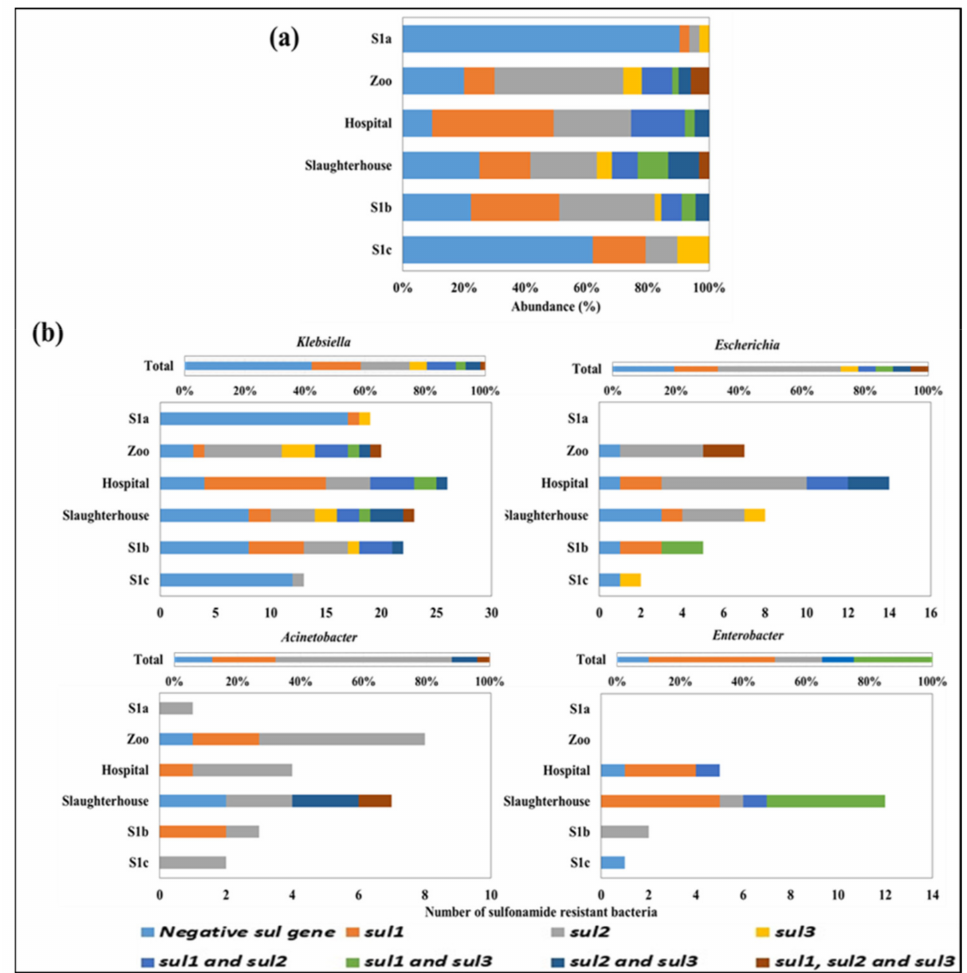
Figure 6. ( a ) Sul genotypes across sampling sites and ( b ) in the most abundant sulfonamides- resistant